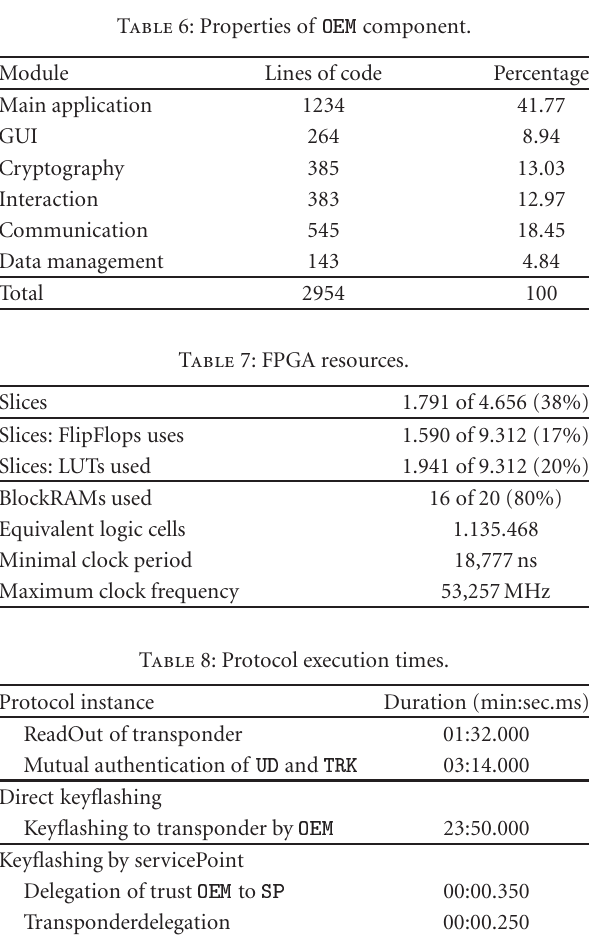
Table 6: Properties of